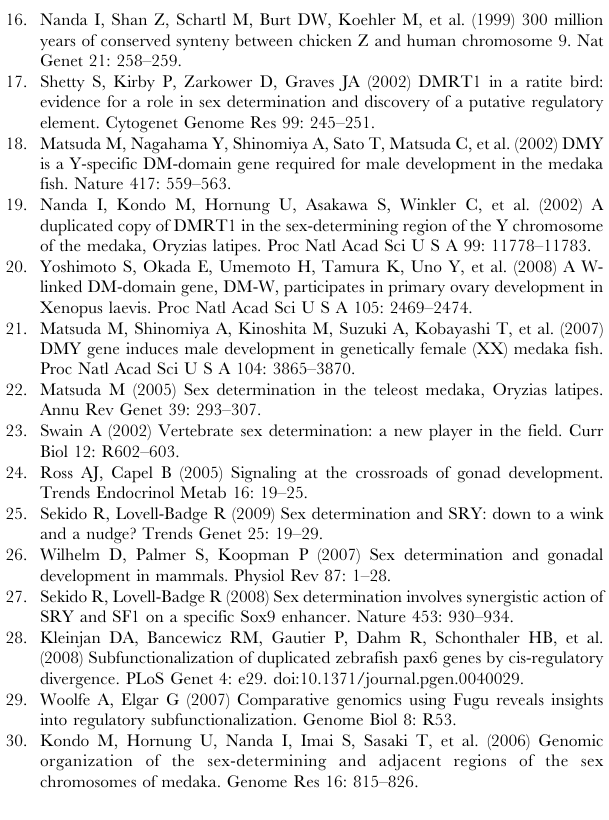
Figure S3 Putative THAP domain in the Izanagi element. (A) Structure of the Izanagi element. Pink boxes indicate the three putative exons constituting the THAP domain are. The insertion of repeat 2 in the dmrt1bY promoter splitting repeat 1 into repeat 1b is indicated by the arrow. Note that the Izanagi element is shown here in reverse complement compared to the dmrt1bY promoter. (B) Alignment of the putative THAP protein domain from the Izanagi element consensus sequence with the THAP domain from the PFAM database. Identical essential residues are yellow shaded; other identical residues are blue shaded. + indicates similar residues. Found at: doi:10.1371/journal.pgen.1000844.s003 (1.01 MB PDF) Figure S4 Repeat elements and transcription factor binding sites in the dmrt1bY promoter. The three segments correspond to the regions used for transcriptional regulation analysis. Transcription factor binding sites conserved with the dmrt1a promoter are boxed. Of particular importance for transcriptional regulation of dmrt1bY might be the repeat 1b area (beige box) with multiple Sox5 and Pax2 binding sites, as well as a Dmrt1 binding site (red). Further upstream, two SF1 binding sites are located (red). For further characterization see Figure 1A and Table 1. Prog Rec: progesterone receptor; Est Rec: estrogen receptor; And Rec: androgen receptor binding sites. Figure S5 Activity of dmrt1bY promoter deletion constructs in different cell lines. (A–C) Various 5 9 -deletions mutants (3 Kb and 6 Kb) from pBSII-ISceI::9 Kb dmrt1bY prom::GLuc plasmid were transfected either into Mouse TM4 Sertoli, Xiphophorus embryonic epithelial A2 or medaka HN2 fibroblast like cells. Transfections were repeated three times; error bars represent the standard errors of the means. Found at: doi:10.1371/journal.pgen.1000844.s005 (0.62 MB PDF)